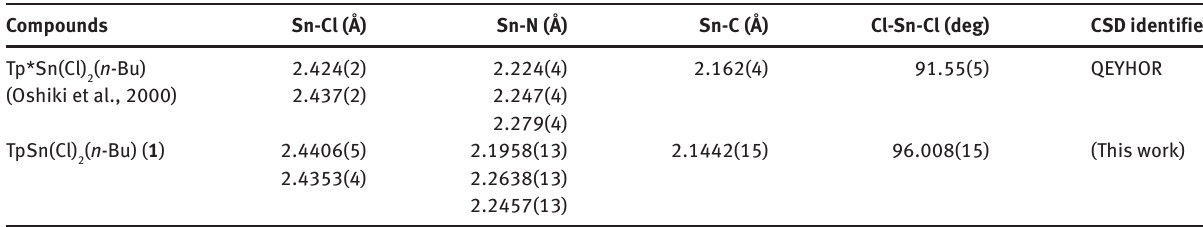
Table 1: Comparison of Sn-Cl, Sn-N, and Sn-C bond lengths (Å), and Cl-Sn-Cl angles (deg) in Tp*Sn(Cl) TpSn(Cl) ( n -Bu) ( 1 ). 2 Compounds Sn-Cl